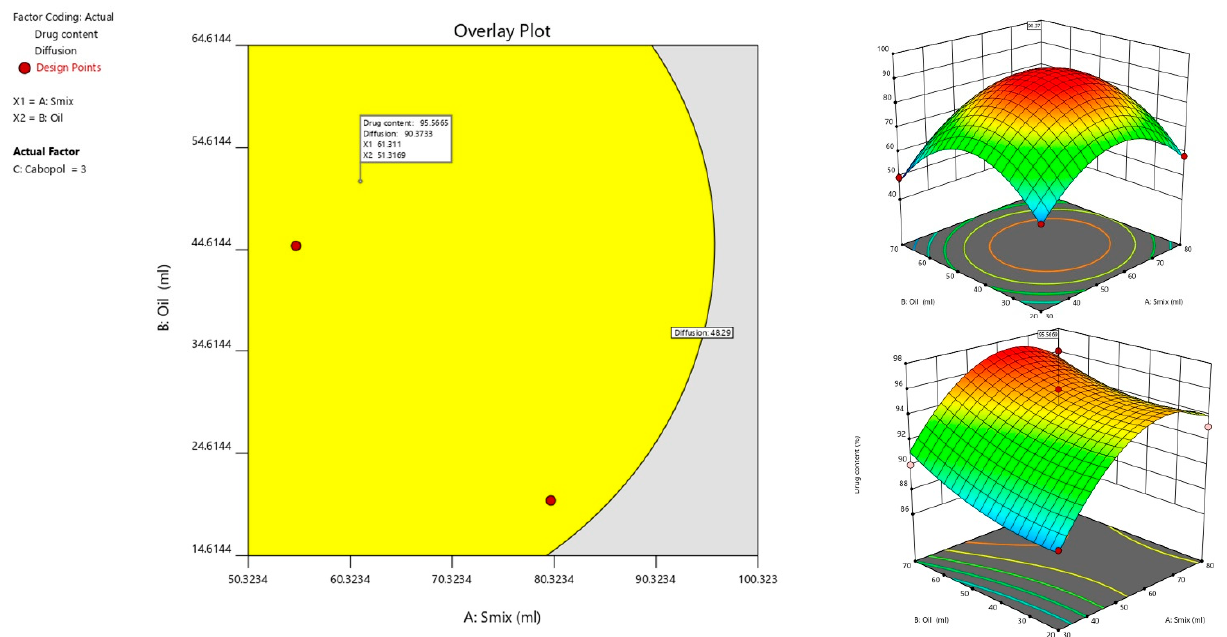
Figure 7 . Optimization of the transemulgel formulation. Figure 7. Optimization of the transemulgel